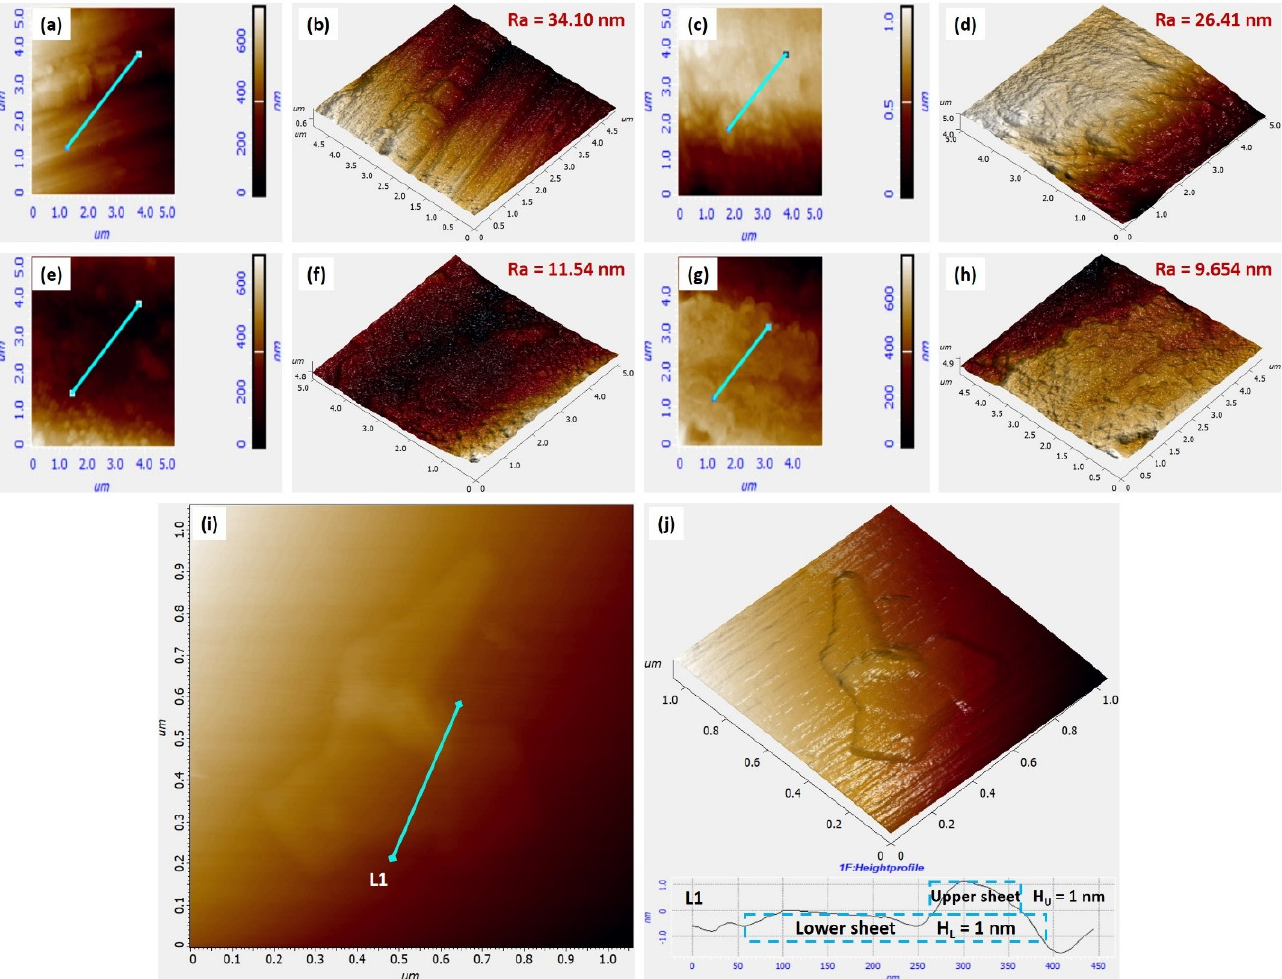
Figure 2. AFM images of ( a ) 2D and ( b ) 3D profile of bare Mg with roughness value, ( c ) 2D and ( d ) 3D profile of EPD-GO-A coated Mg sample with roughness value, ( e ) 2D and ( f ) 3D profile of EPD-GO-E coated Mg sample with roughness value, ( g ) 2D and ( h ) 3D profile of EPD-GO-W coated Mg sample with roughness value, ( i ) 2D & ( j ) 3D profile of GO sheets with height profile.